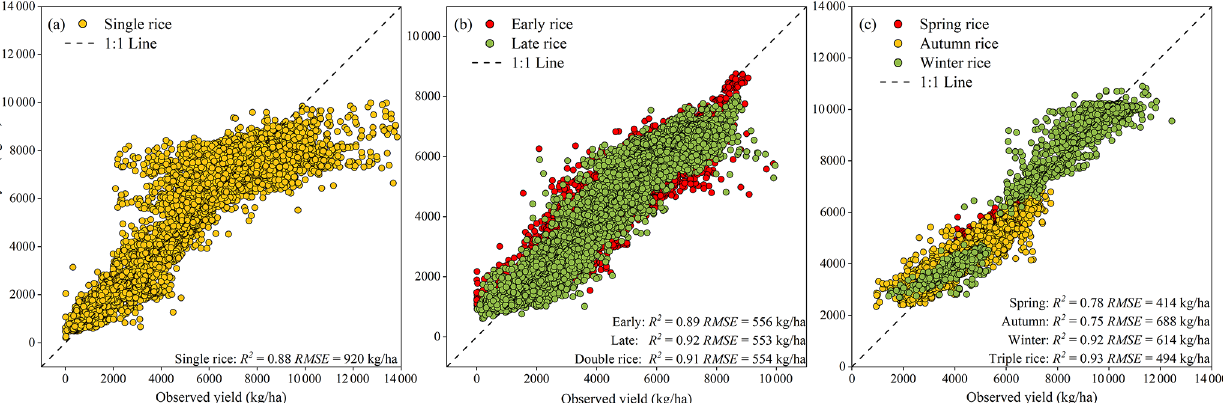
Figure 4. Comparison of AsiaRiceYield4km with observed yields at the administrative-unit scale for (a) single rice, (b) double rice and (c) triple